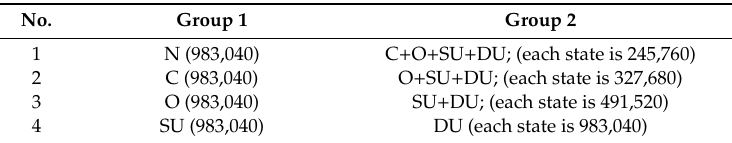
Table 2. Description of experimental data